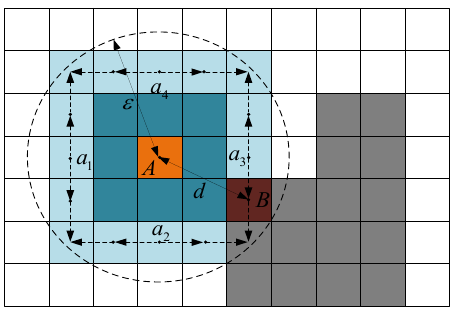
Figure 7. Schematic of the searching order of grids within one layer. 1. First, search all grids in the n -th ( n = 1, 2, 3, . . . N ) layer that encloses A . The maximum number of the layer N = (cid:100) ε / l (cid:101) ( (cid:100)·(cid:101) indicates an upward rounding). 2. During the search of grids in each layer, the four grids in the horizontal and vertical directions are searched preferentially, and are shown as a 1 , a 2 , a 3 , a 4 in Figure 7. If neither of the searched grids is the obstacle grid, the upward and downward adjacent grids of a 1 and a 3 are searched, respectively. Similarly, the left and right adjacent grids of a 2 and a 4 are searched, respectively.